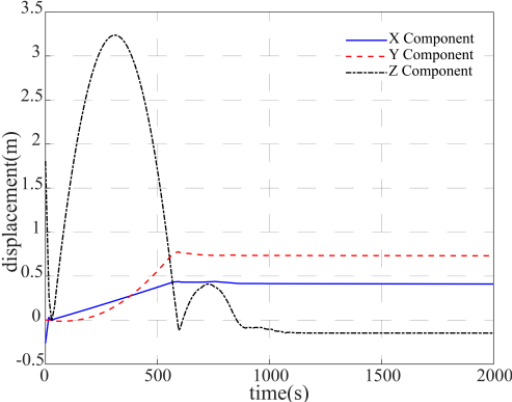
Figure 10. The distance between the flexible lander and the targeted landing site.